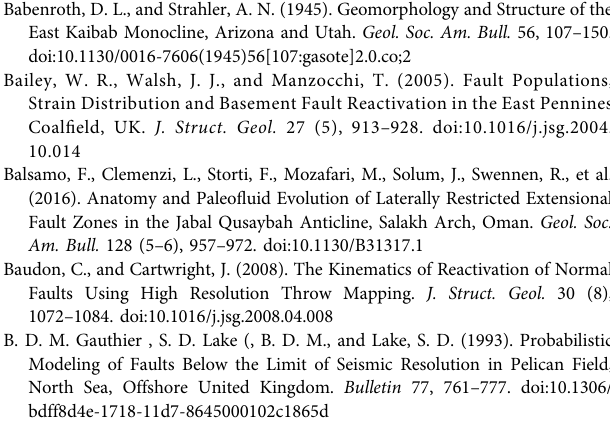
Supplementary Figure S3 | Plots showing normal fault D/L data for normal faults with host rocks of different lithologies included in our dataset, including carbonate, clastic, evaporites, fi ne-grained carbonate, fi ne-grained clastic, mixed carbonate/ clastic, unlithi fi ed sediments, igneous, and igneous/clastic, separated by order of